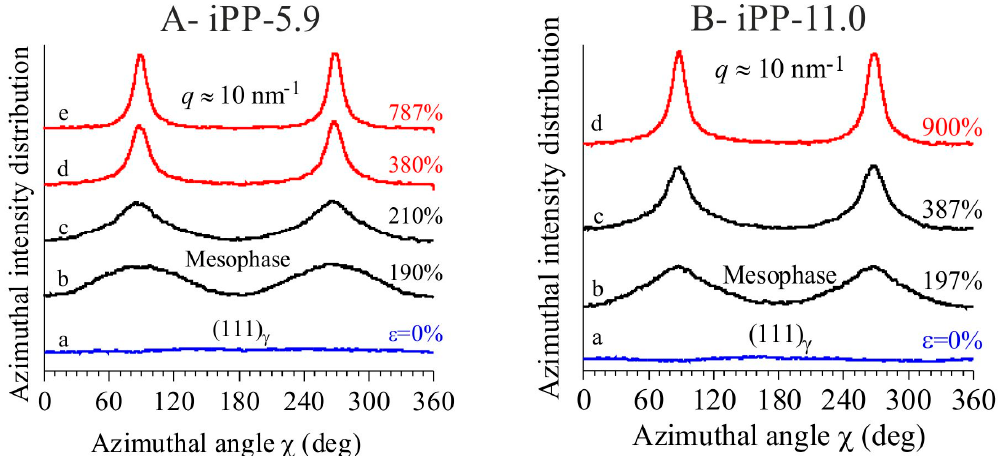
Figure 3. Azimuthal profiles of intensity centered in the q region around 10 nm − 1 , extracted from the bidimensional WAXS images of Figure 1 for the samples iPP-5.9 ( A ) and iPP-11.0 ( B ). The intensity at q ≈ 12 nm − 1 relative to the (008) γ reflections of γ form (curves a of Figure 2), instead, at low deformations is polarized on a layer line off the equator (horizontal direction) and off the meridian (vertical direction), as indicated by the arrows in the images b, c of Figure 1, and only when the transformation into the mesophase is complete, that is, at deformations higher than ε end , the intensity at q ≈ 12 nm − 1 becomes polarized on the equator [19,20]. This indicates that part of the crystals of the initial γ form tend to become oriented at low deformations with the chain axes nearly perpendicular to the stretching direction, as shown in Figure 4, instead than parallel as in the standard fiber morphology [16,38]. It is worth noting that for the perpendicular chain axis orientation of γ form, the polarization of the (111) γ (at q ≈ 10 nm − 1 ) reflection occurs on the equator [39].